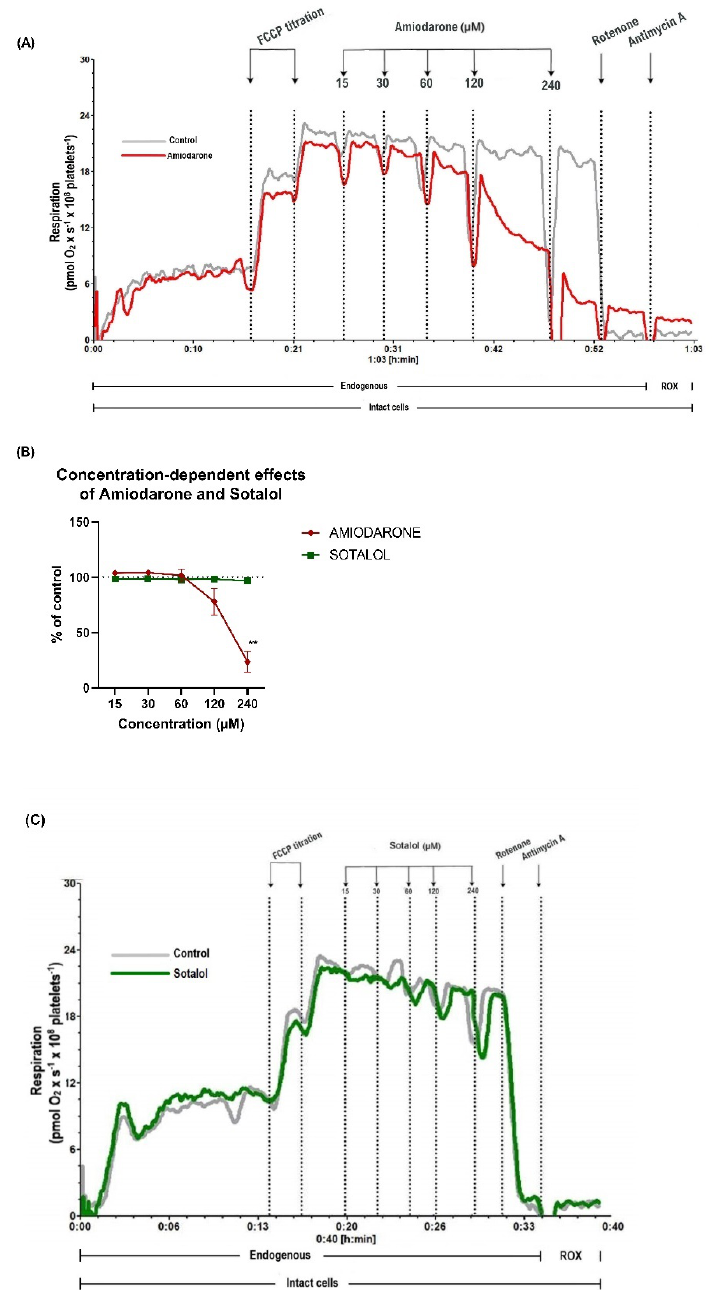
Figure 1. Amiodarone, but not sotalol, induced concentration-dependent impairment of mitochondrial respiration in intact platelets. ( A ) Representative trace of amiodarone-induced mitochondrial dysfunction (amiodarone-red; DMSO-grey). ( B ) Respiration of human platelets was measured after submaximal uncoupling with FCCP (2 µ M). The concentration-dependent effect of amiodarone (red rhombus) and sotalol (green square) was measured by titrating increasing concentrations of each drug (15–240 µ M) vs. the equivalent volume of vehicle (DMSO or H 2 O). Non-mitochondrial respiration was evaluated by the inhibition of complex I with rotenone (2 µ M) and complex III with antimycin A (1 µ g/mL). ( C ) Representative trace of sotalol effect on mitochondrial respiration (sotalol-green; H 2 O/solvent-grey). Data were expressed as mean ± SEM. Two-way ANOVA with Bonferroni post hoc test was performed on the antimycin-corrected data. ROX: residual oxygen consumption. DMSO: dimethyl sulfoxide. FCCP: carbonyl cyanide p-(trifluoromethoxy) phenylhydrazone. ** p < 0.01 vs. DMSO. n =